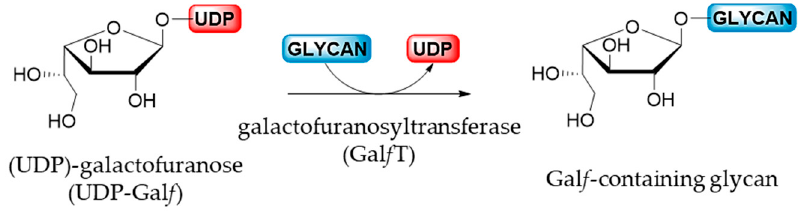
Figure 7. Biosynthesis of Gal f -glycan catalyzed by Gal f T.